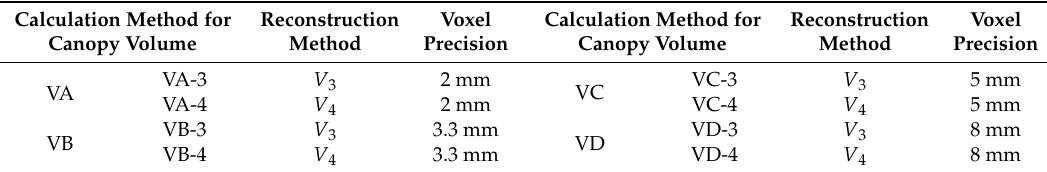
Table 3. GTP canopy volume calculation